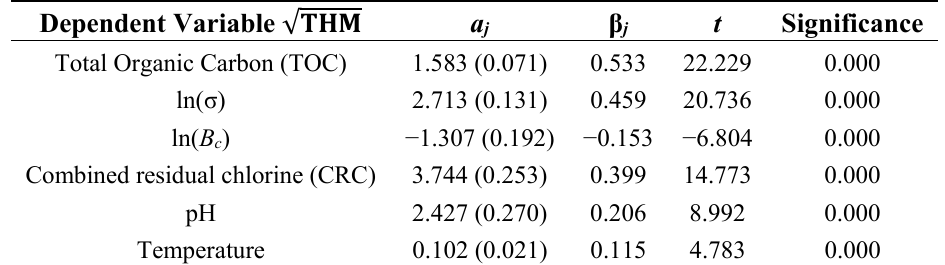
Table 2. Statistical summary of coefficients for the variables in the regression model. Dependent Variable √(cid:1794)(cid:1782)(cid:1787)